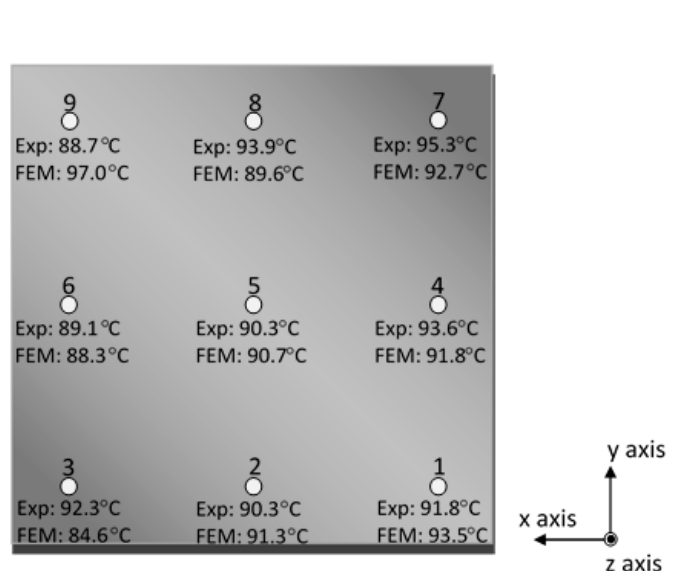
Figure 4. Experimentally obtained temperature values in comparison with numerically calculated ones throughout the 10th layer’s surface (building time: 1500–2000 s).